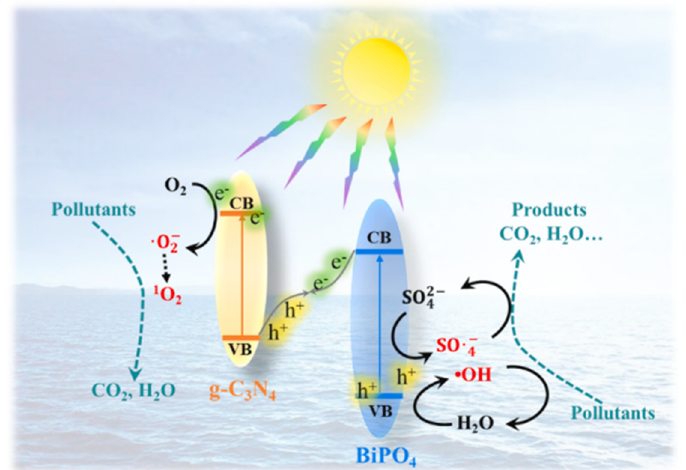
Figure 7. ROS formation catalyzed by a heterostructure. Reproduced from [137]. Copyright 2022, Elsevier.